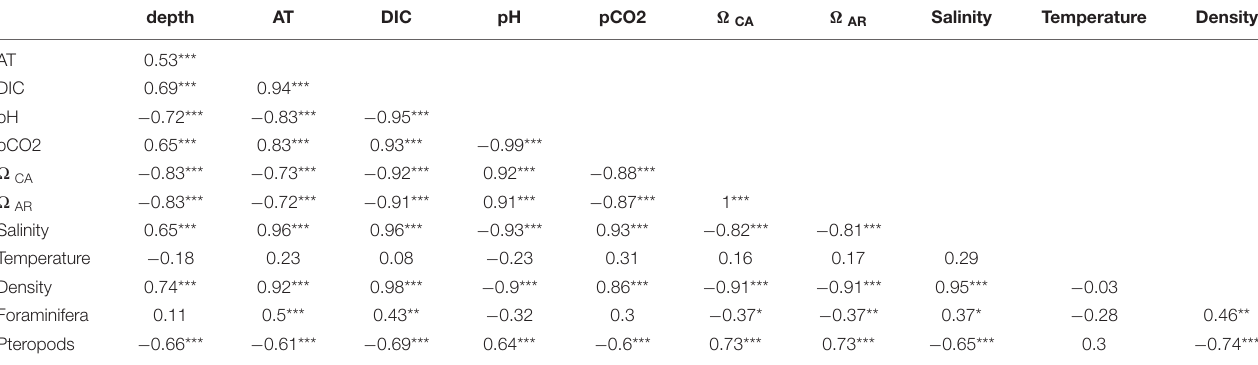
TABLE 7 | Correlation table between environmental parameters, carbonate chemistry and distribution of planktic foraminifera and pteropods. depth AT DIC pH pCO2 (cid:127) CA (cid:127) AR Salinity Temperature Density